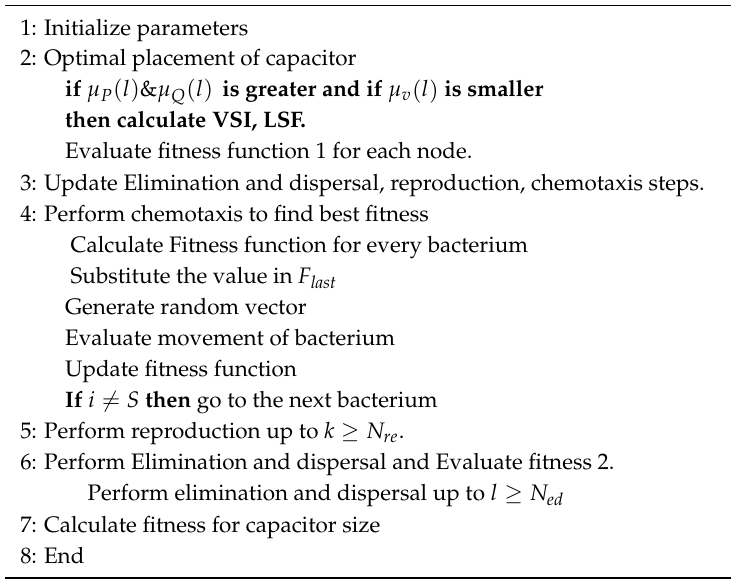
Algorithm 1 Pseudo code of